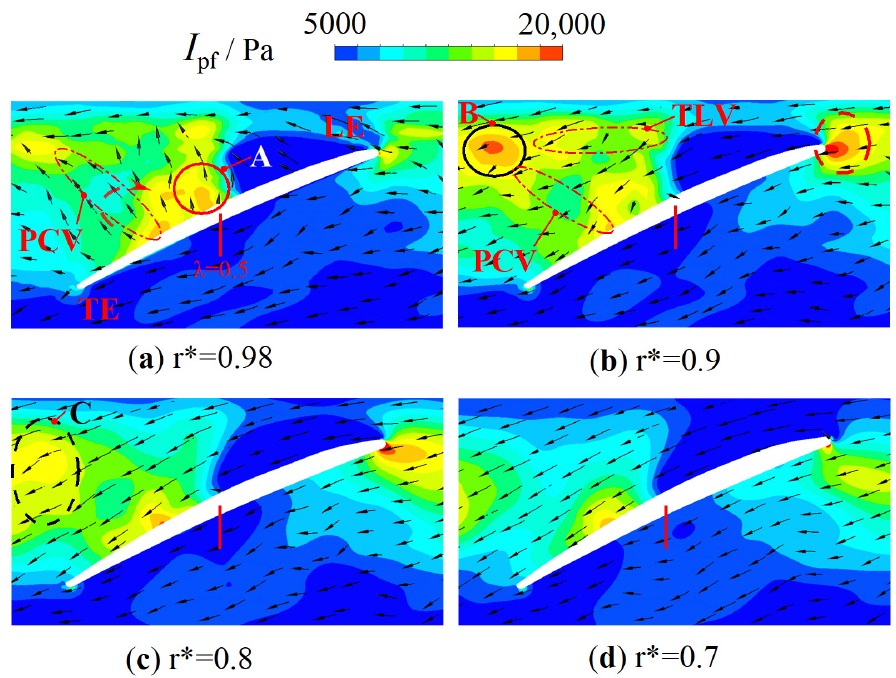
Figure 18. Distribution of the intensity of pressure fluctuation on radial sections ( Q = 0.8 Q BEP , σ = 0.35).